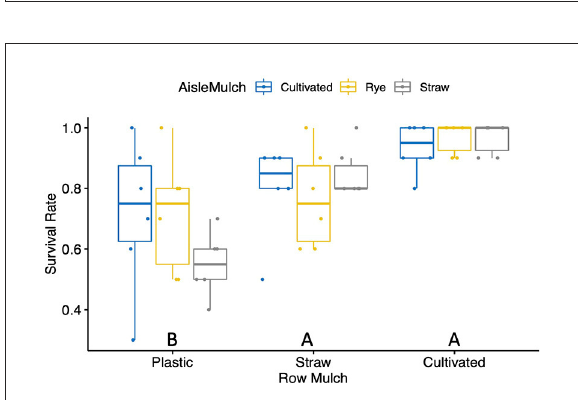
FIGURE2 Proportion of squash plants surviving until fruit maturity by row and aisle mulches. Uppercase letters indicate significance groupings for row mulches. Groups with the same letter (or no letter) were not significantly different across years and aisle treatments at p < 0.05.